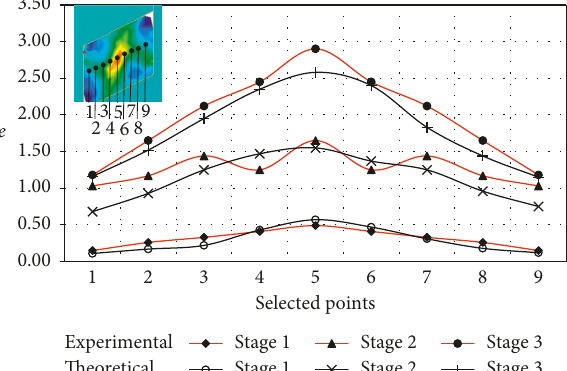
Figure 7: Distribution of accumulated strain for theoretical and experimental data for 3 operations of deformation at the RS-60